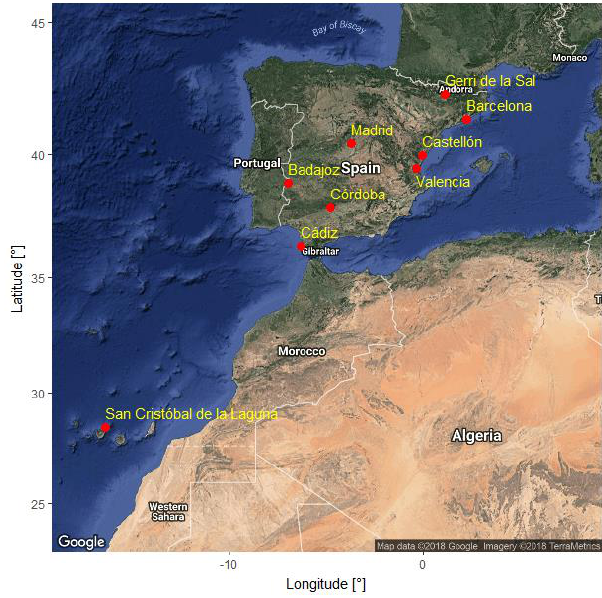
Figure 1. Locations (red dots with yellow letters) in a modern map where a noticeable aurora was registered in Spain on 18 Jan- uary